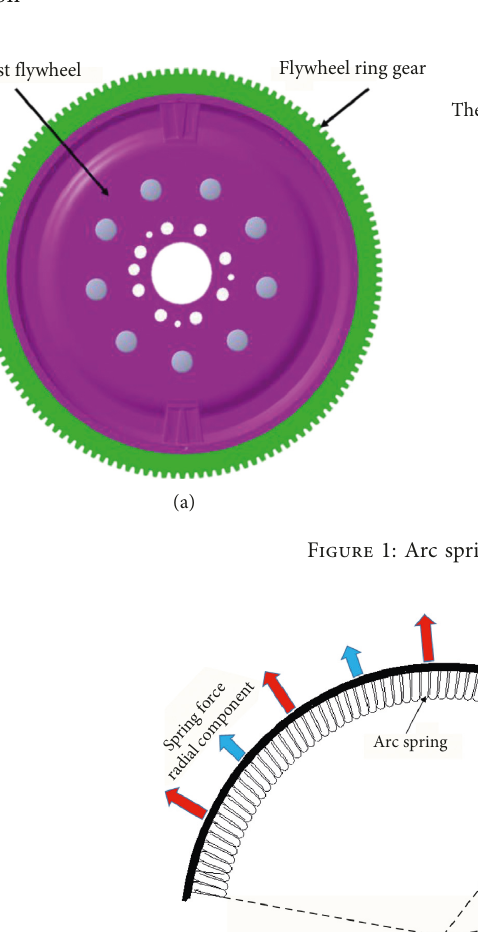
Figure 2: Diagram of frictional moment of arc